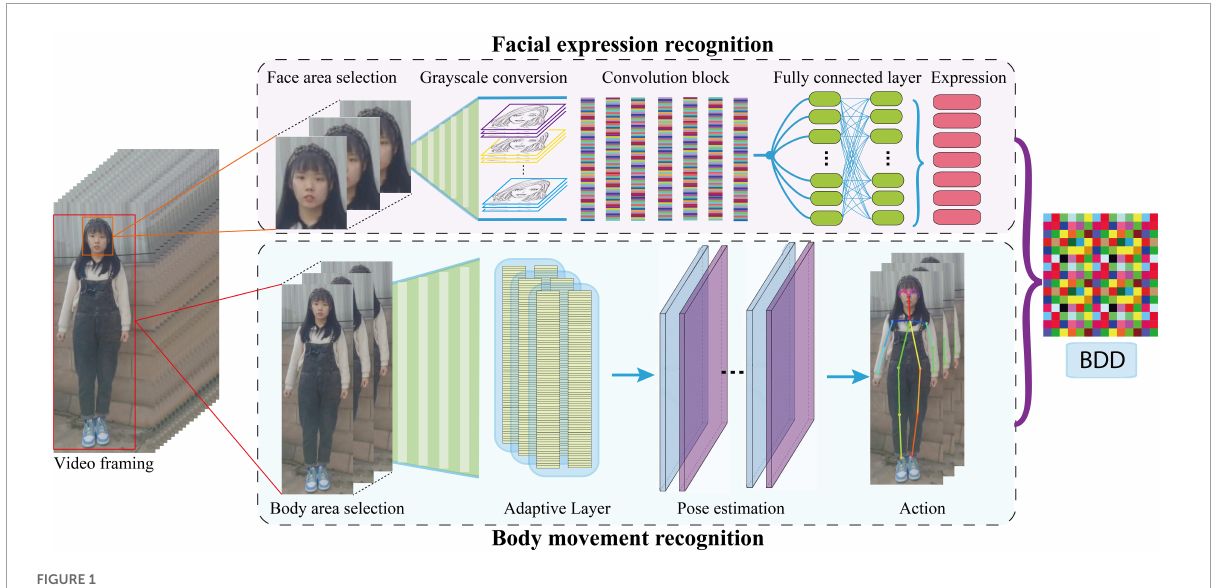
FIGURE1 Overview of the proposed